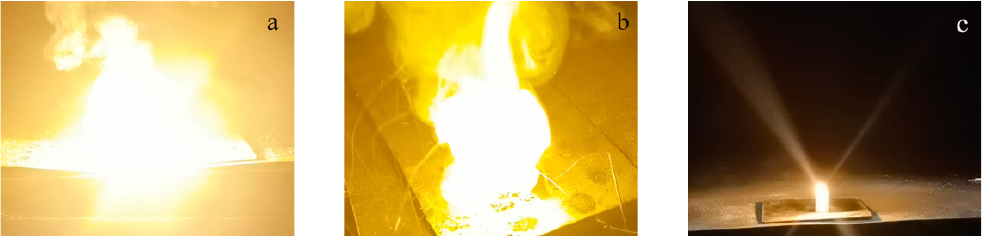
Figure 5. Flame color during combustion: ( a ) illuminant; ( b ) combustible illuminant shell; ( c ) resin pillar.